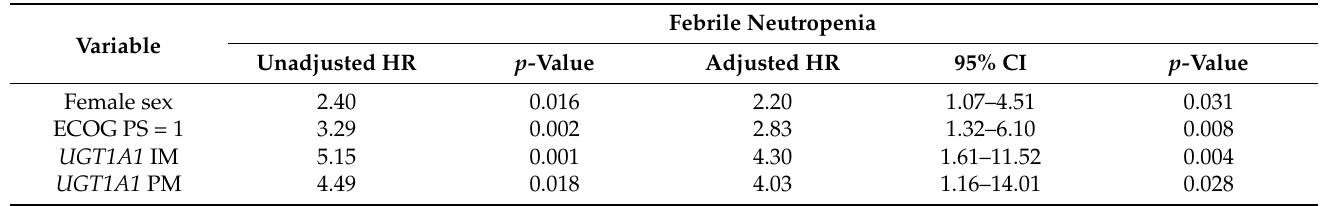
Table 4. Multivariate analysis using Cox regression analysis to identify risk factors for febrile